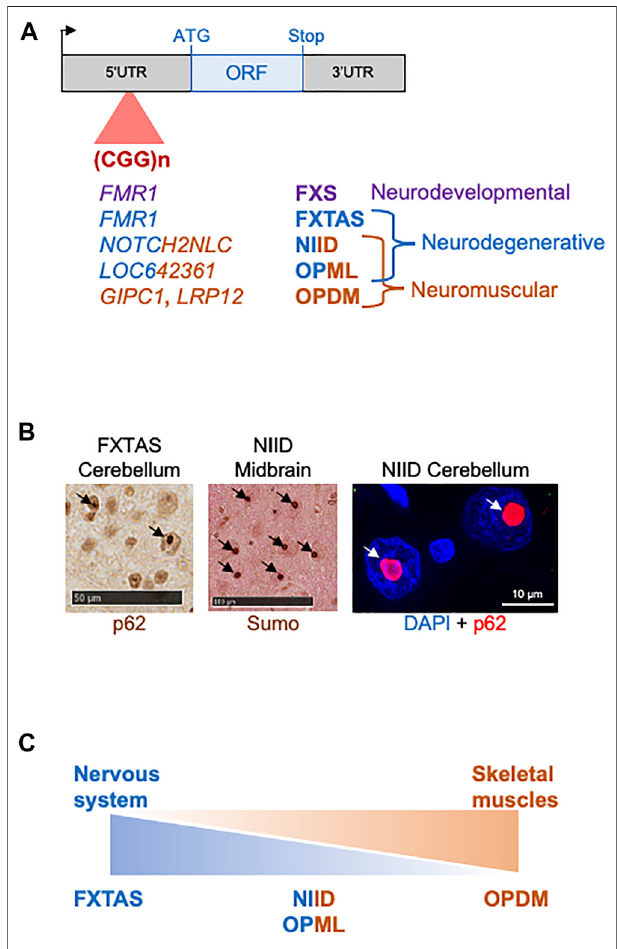
FIGURE 1 | CGG repeat expansions cause a spectrum of disease. (A) Identical CGG repeat expansions embedded within the 5 ′ UTR of different genes cause various neurodevelopmental, neuromuscular and neurodegenerative disorders. (B) Brain sections of individuals with FXTAS or NIID show identical p62-or sumo-positive intranuclear inclusions. (C) FXTAS, NIID, OPML, and OPDM may belong to a continuum of neuromuscular and neurodegenerative